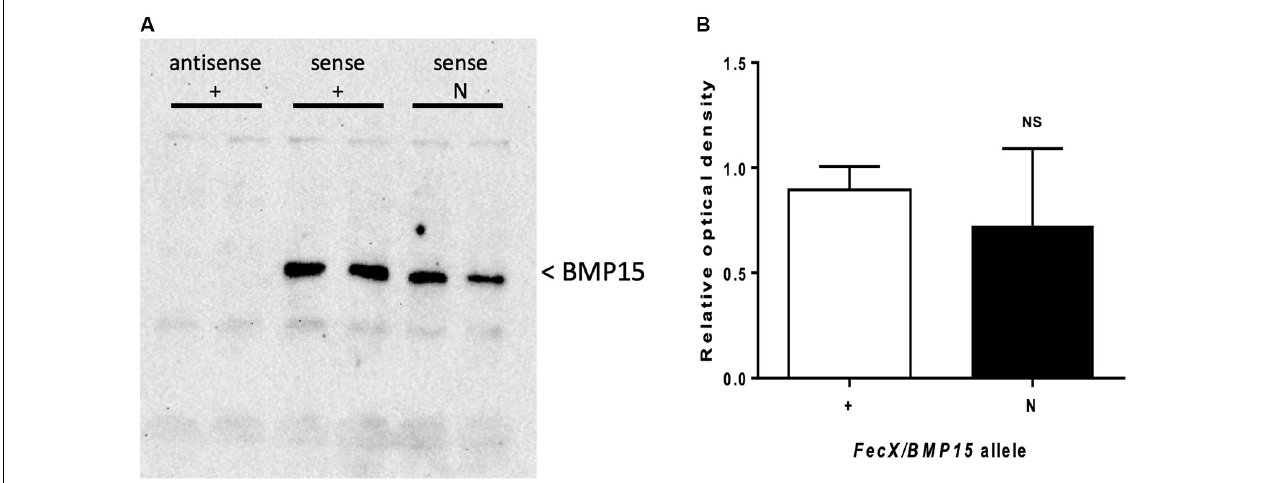
FIGURE 6 | Effect of FecX N mutation on the ovine BMP15 protein produced in vitro. In vitro transcription and translation were realized in duplicate in six independent experiments from antisense BMP15 cDNA carrying the wild-type allele (antisense +) as negative control or sense BMP15 cDNA with (sense N) or without FecX N (sense +). (A) A representative western blot experiment revealing the BMP15 protein. (B) Chemiluminescent signal of BMP15 was captured by a ChemiDoc MP imaging system and images were quantified (relative to sense +) and analyzed with the Image Lab Software (Bio-Rad). Means ( ± SEM ) were not significantly different (NS) after Student’s T- test with Welch’s correction.